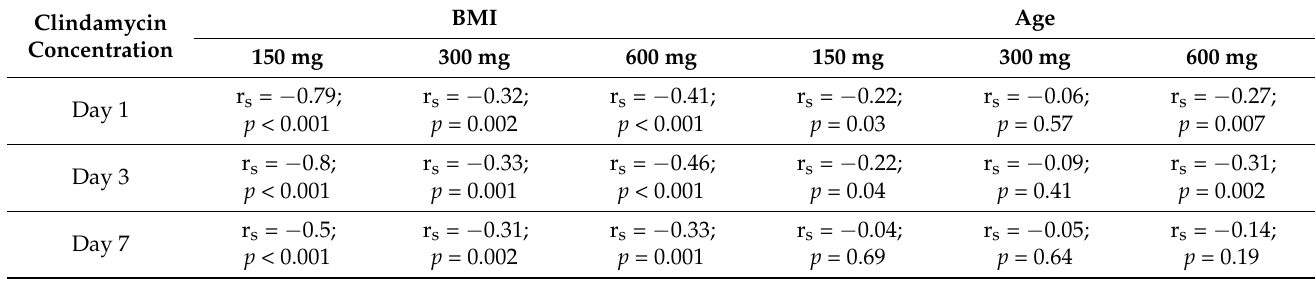
Table 10. Relationship between BMI, age, and clindamycin concentration in each